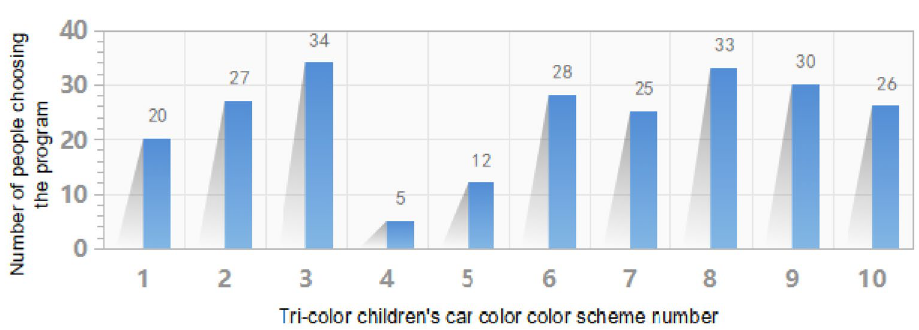
Figure 5. Summary of subjective findings in the